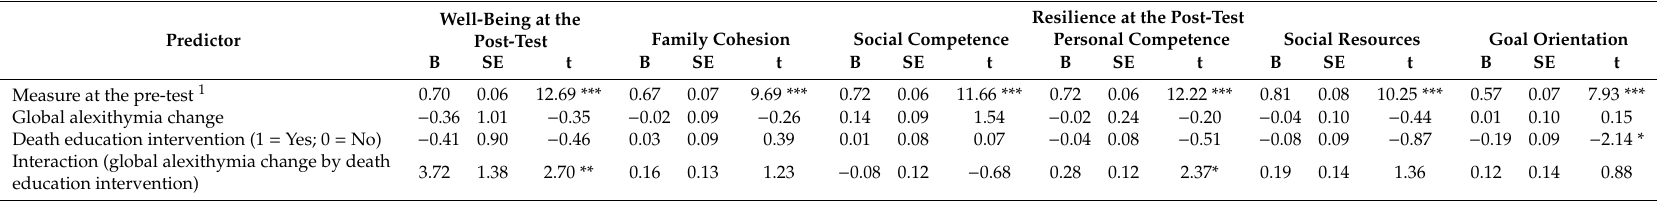
Table 3. Moderation e ff ect of death education intervention on the impact of global alexithymia change on student’s well-being and resilience at the post-test.